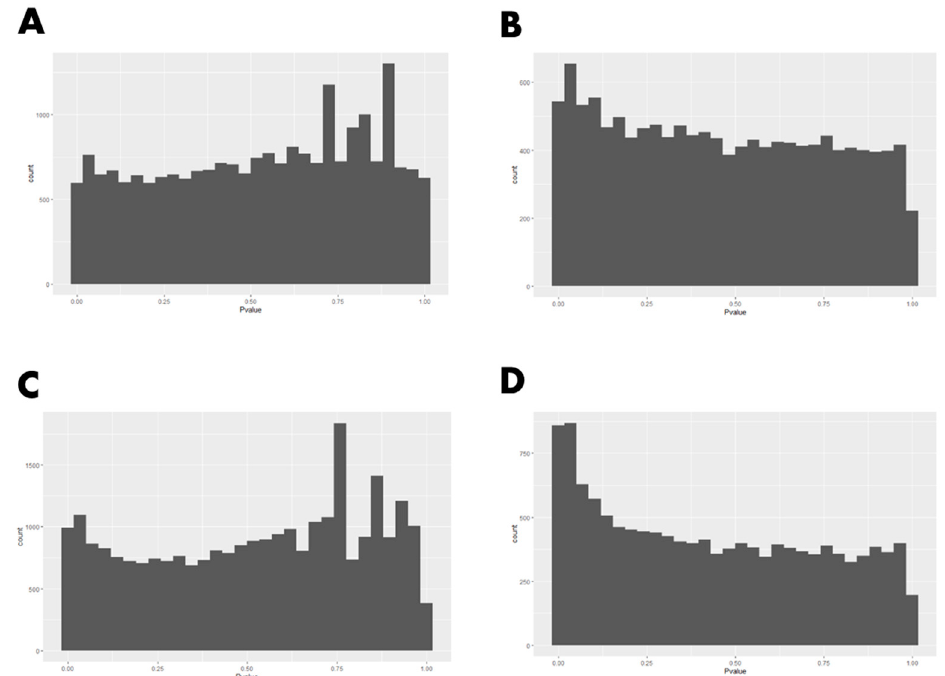
Figure 3. Raw p -value histograms for before and after filtering genes using HTSFilter package. ( A ) U.S. data set before filtering; ( B ) U.S. data set after filtering; ( C ) Canadian data set before filtering; ( D ) Canadian data set after filtering.